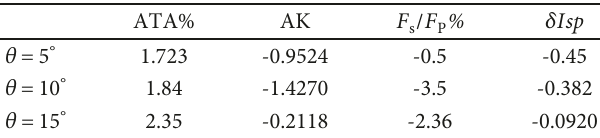
Table 11: SITVC performance parameters with respect to divergence half angle at M